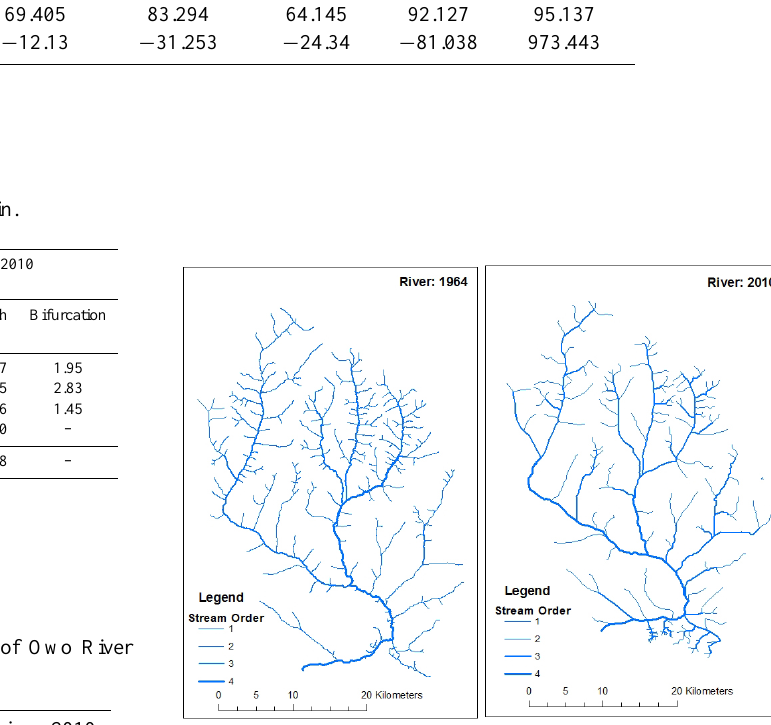
Figure 6. Morphodynamic characteristics of Owo River Basin be- tween 1964 and